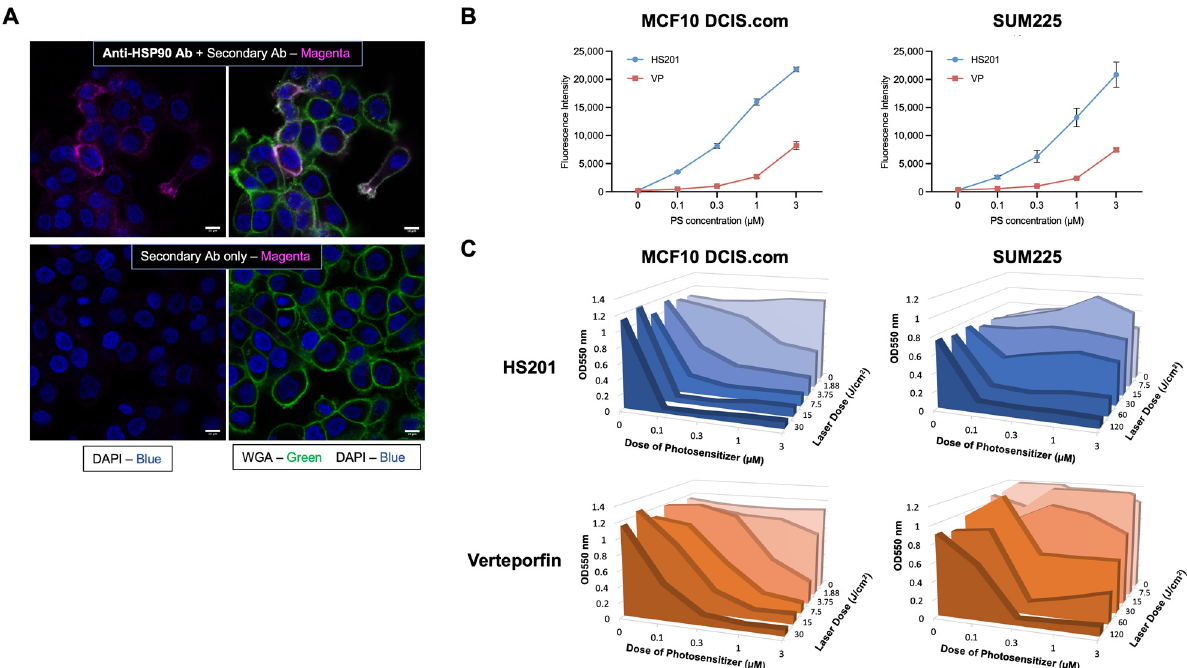
Figure 1. In vitro uptake of HS201 and cytotoxicity of HS201-PDT against human DCIS cell lines. ( A ) Cell surface expression of Hsp90 on DCIS cells. MCF10DCIS.com cells cultured on glass-bottom dishes were incubated with or without anti-Hsp90 antibody (clone AC88, Abcam) for 30 min on ice, then fixed with 10% neutral buffered formalin. Then, cells were incubated with AF568-conjugated goat anti-mouse IgG, followed by WGA AF488 conjugate membrane staining dye and DAPI. After being washed with PBS, cells were observed using a confocal microscope. Upper images: with anti- Hsp90 antibody. Bottom images: secondary antibody alone. Magenta: Hsp90, Green: cell membrane, Blue: DAPI. Scale bars: 10 µm. ( B ) In vitro uptake of photosensitizers HS201 and parental VP by human DCIS cell lines. MCF10DCIS.com and SUM225CWN cells were cultured in 96-well plates, and VP or HS201 (0.03–3 µM, respectively) was added, incubated for 30 min at 37 °C and then washed with PBS. The signal intensity of each well was measured at 700 nm by LI-COR Odyssey imager. ( C ) Cytotoxicity of in vitro PDT using VP (VP-PDT) and HS201 (HS201-PDT) determined by MTT assay. DCIS cells in a 96-well plate were co-incubated with PS and washed as described in Figure 1B. A laser with a wavelength of 690 nm was applied at various doses (1.88–120 J/cm 2 ) to each well, and cells were incubated overnight prior to the analysis. An MTT assay was performed, and the optical density values at 550 nm (650 nm subtracted) are shown.